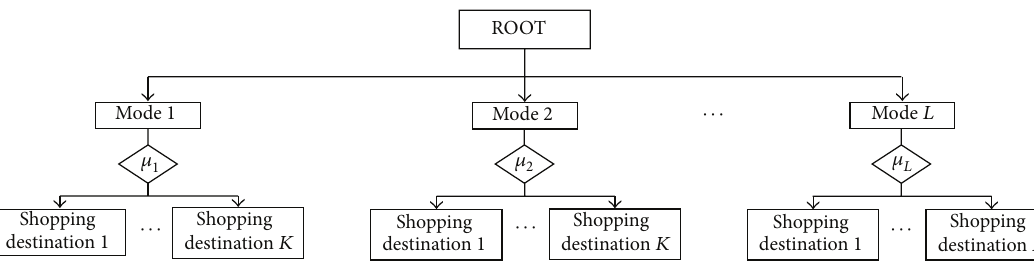
Figure 3: Structure of two-level NL model, using nesting along travel mode